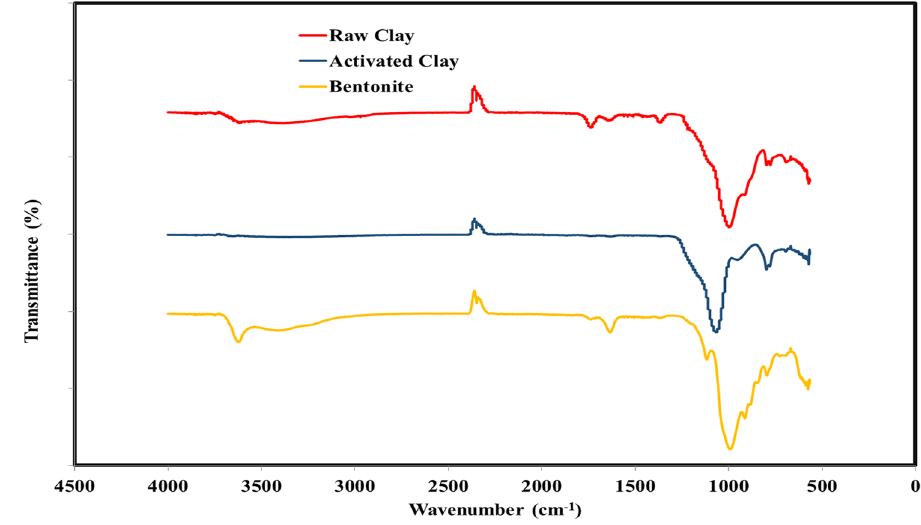
Fig. 8 FTIR spectra of the com- mercial bentonite and the clay (before and after